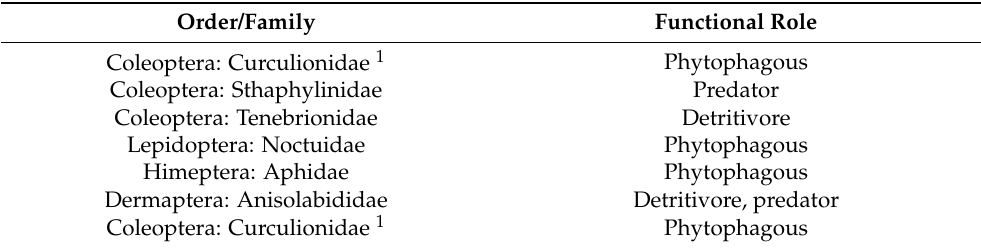
Table 4. Insect families collected in soil blocks of quinoa plants removed from plots. The families are ordered in relation to abundance (from highest to lowest).